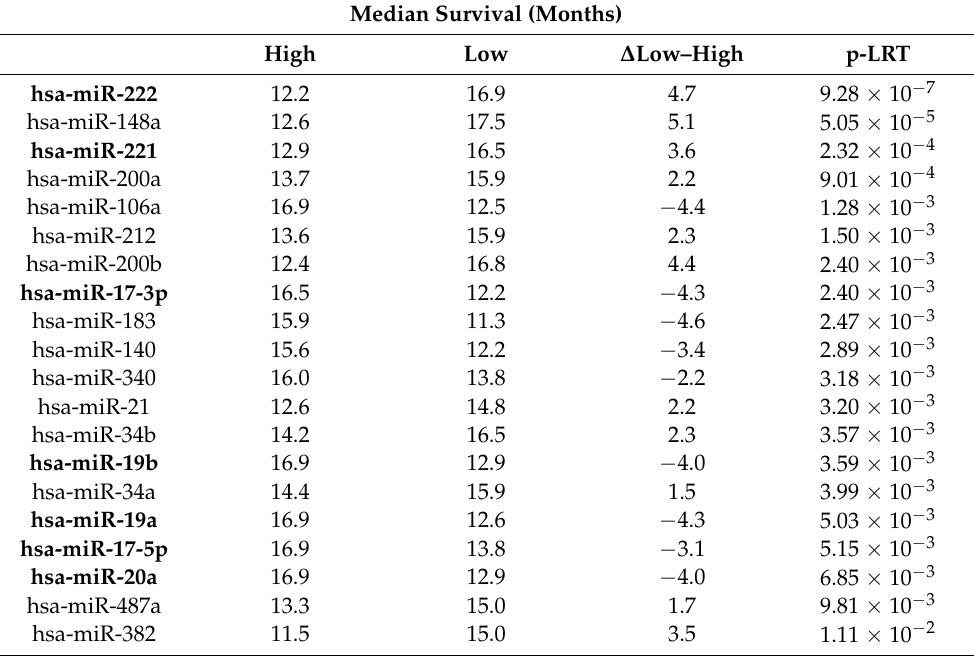
Table 2. The 20 top-ranked miRs from the TCGA glioblastoma multiforme (GBM) cohort associated with prognosis. Median Survival (Months) High Low ∆ Low–High